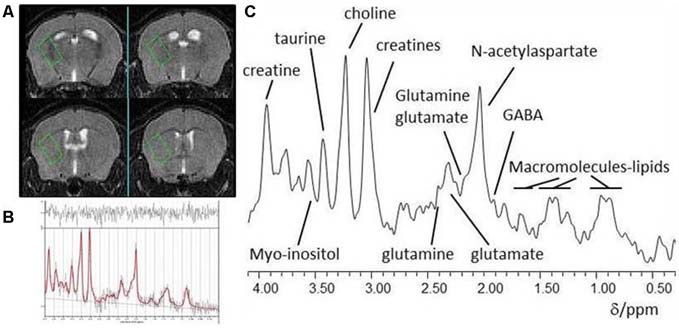
(A) Typical placement of a striatal voxel on T2-weighted pilot MR images of the mouse brain; (B)
In vivo localized 1H-MR spectrum from a striatal voxel and (C) LCModel analysis of a 1H MR spectrum.